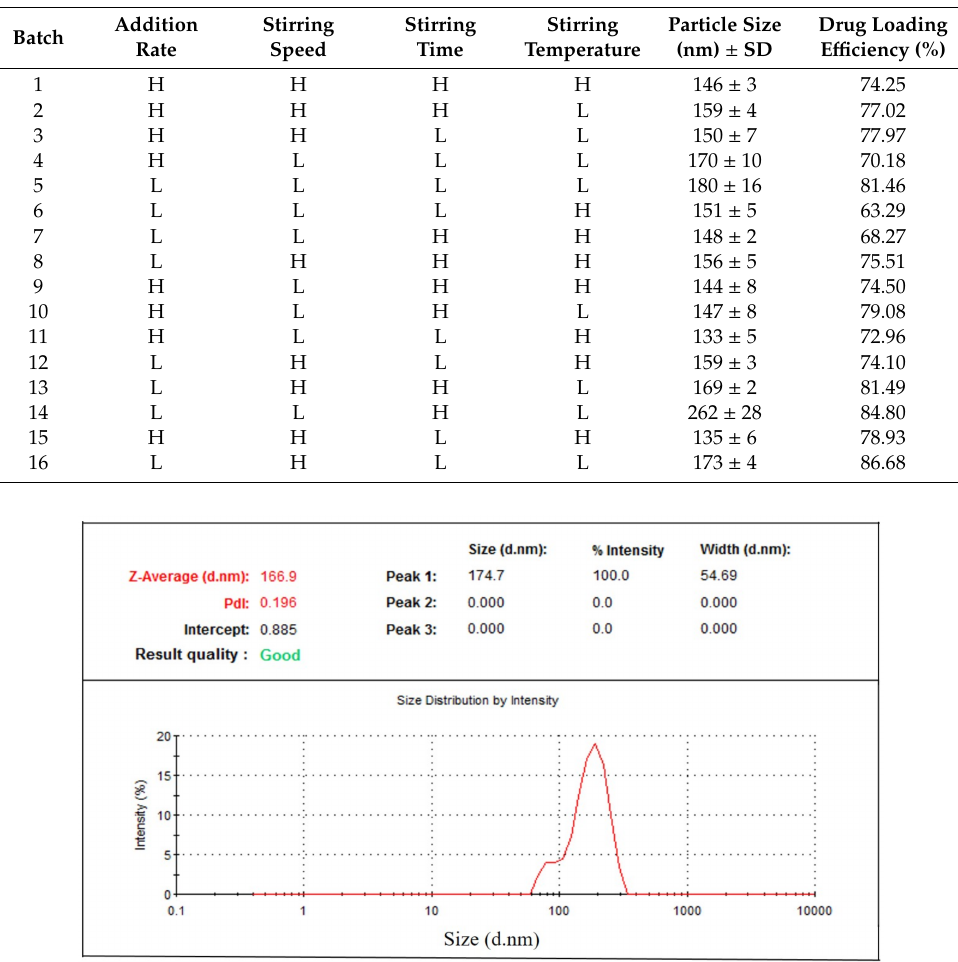
Figure 5. Particle size distribution of green tea extract-loaded